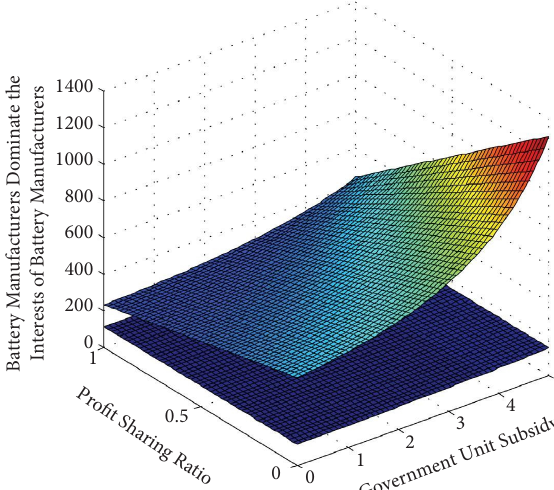
Figure 7: Te impact of proft-sharing ratio and government unit subsidy on the interests of battery manufacturer-led battery